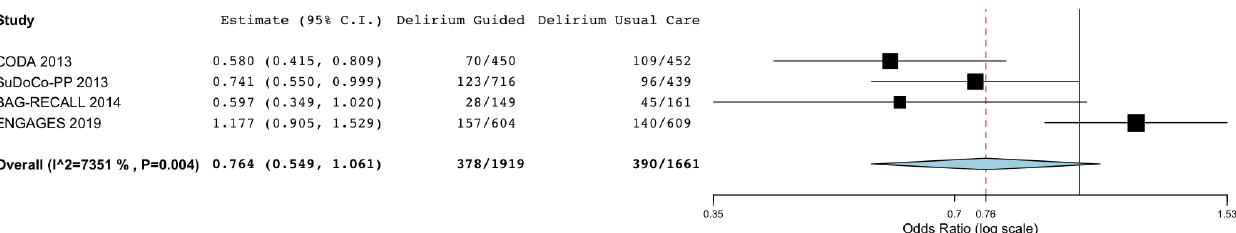
Figure 1. Meta-analysis summarizing four trials in which the intervention group received electroencephalogram-guided anesthesia. This analysis was conducted by using OpenMetaAnalyst 65 and was based on a binary, random effects, Hartung–Knapp–Sidik–Jonkman model 66,67 . The I 2 = 74%, tau 2 = 0.08, Q(df = 3) = 13.234, and heterogeneity P value = 0.004. The estimated odds ratio for delirium with intervention (electroencephalogram-guided [reduction in] anesthesia) = 0.764 (95% confidence interval 0.549 to 1.061, P = 0.108). BAG- RECALL, Bispectral Index or Anesthesia Gas to Reduce Explicit Recall; C.I., confidence interval; CODA, Cognitive Dysfunction after Anesthesia; ENGAGES, Electroencephalography Guidance of Anesthesia to Alleviate Geriatric Syndromes; SuDoCo-PP, Surgery Depth of Anaesthesia and Cognitive Outcome